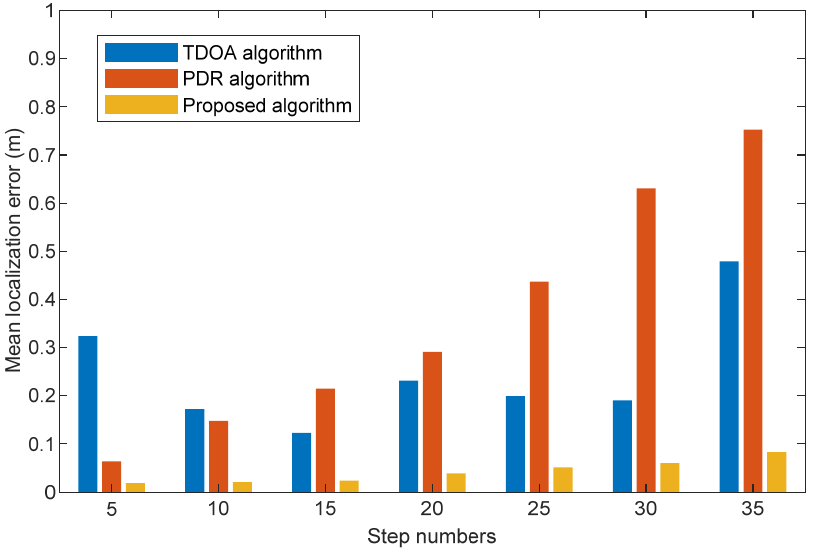
Figure 14. Mean localization error comparison with TDOA algorithm, PDR algorithm, and the proposed algorithm at different step numbers (Second scene).